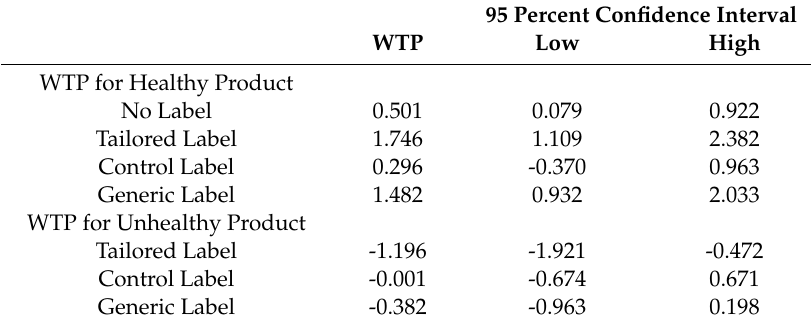
Table 3. WTP estimates for healthy and unhealthy products by labeling condition, relative to an unhealthy product in the no label